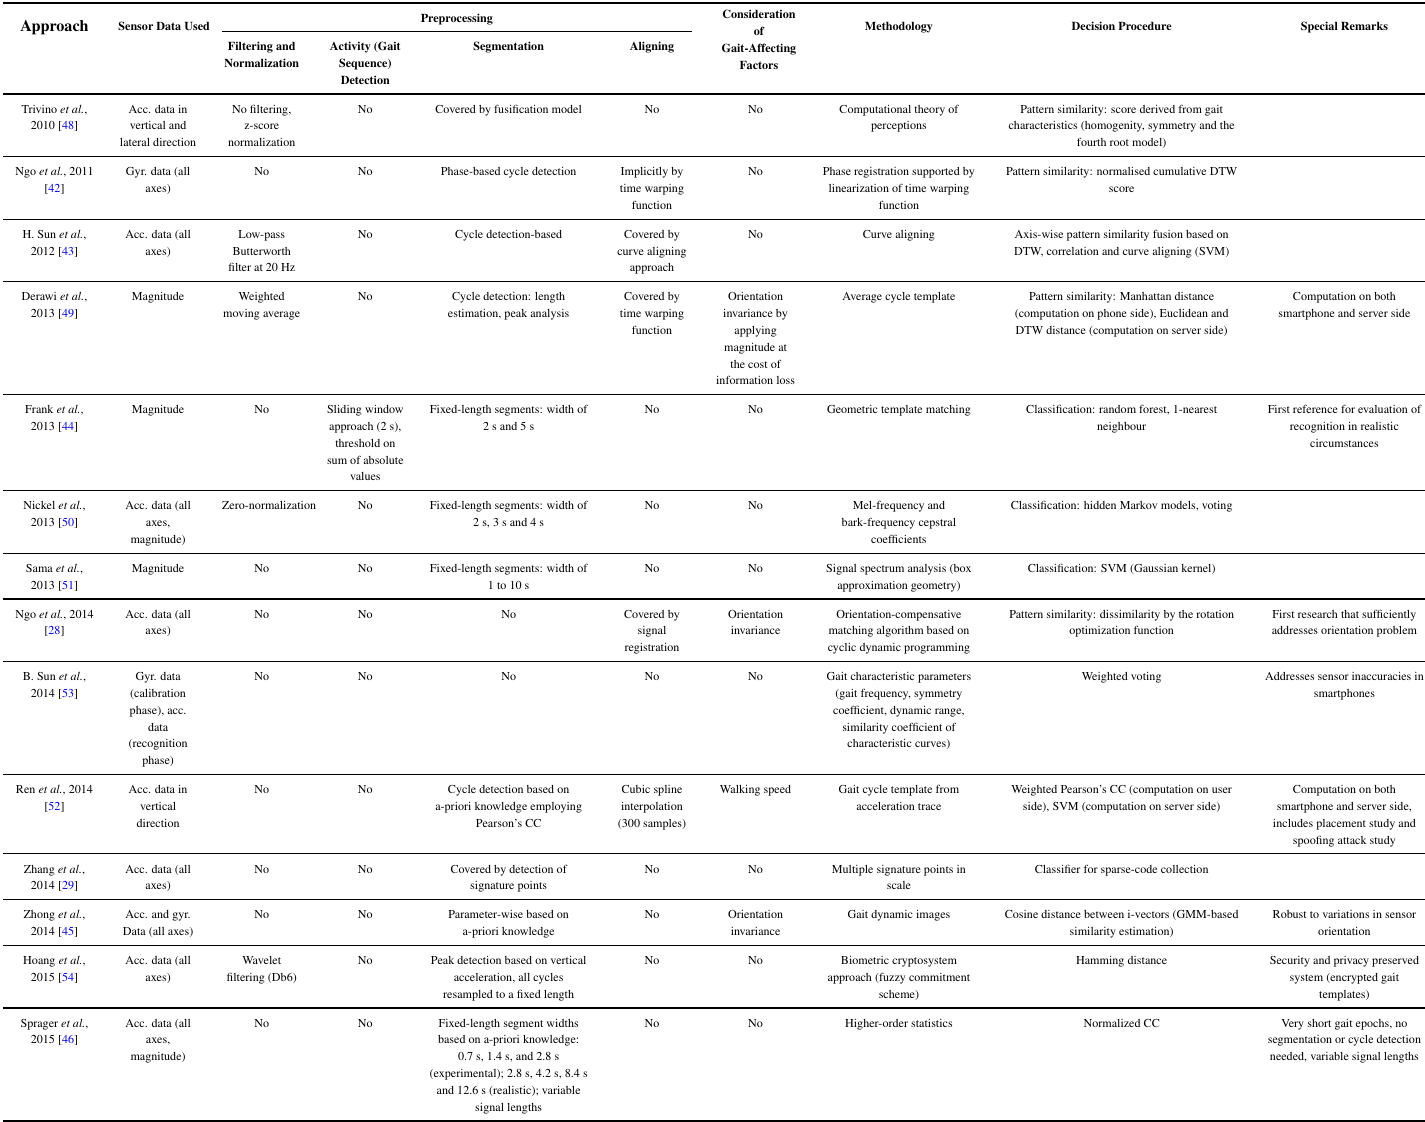
Table 2. Methodological details on representative inertial sensor-based gait recognition approaches. Approach